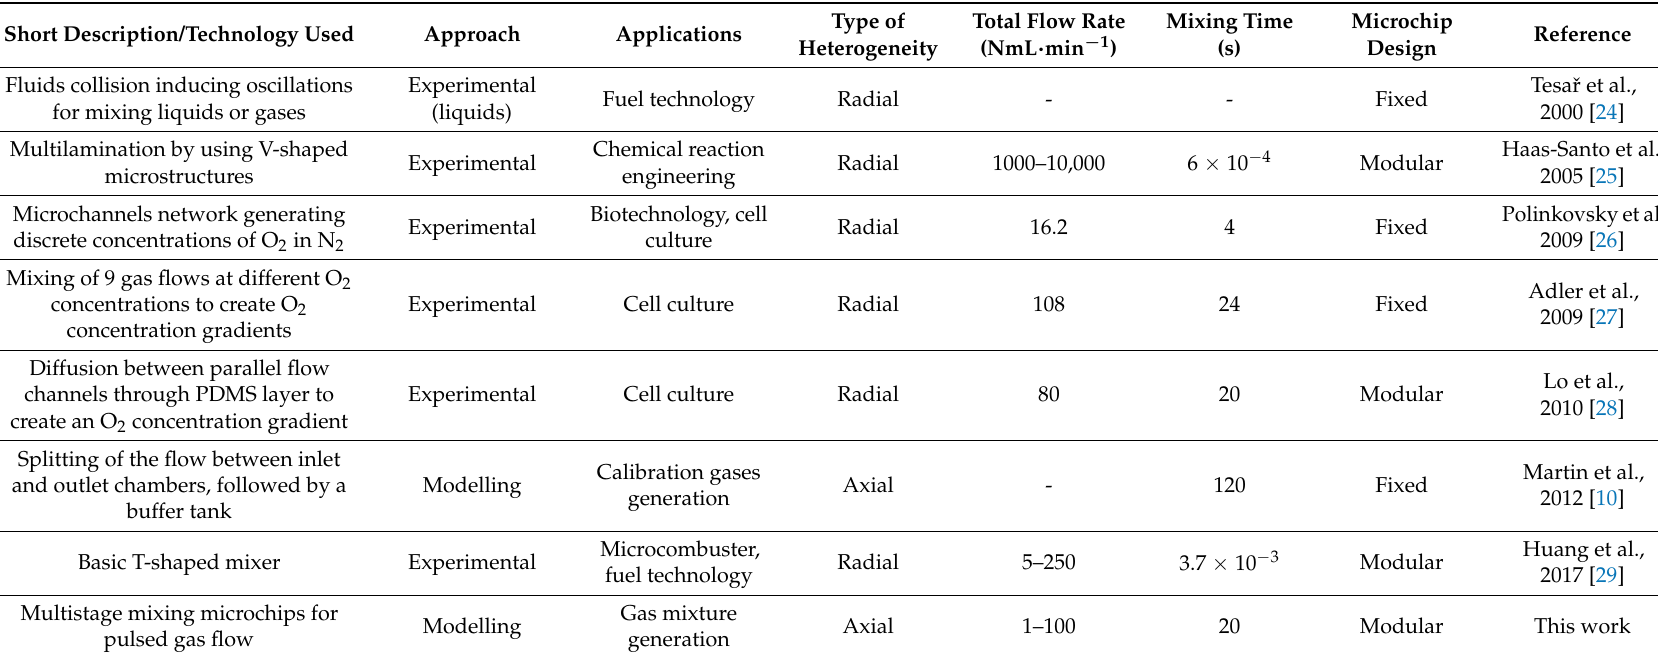
Table 1. Technological solutions used to obtain homogeneous gas mixtures in microfluidic